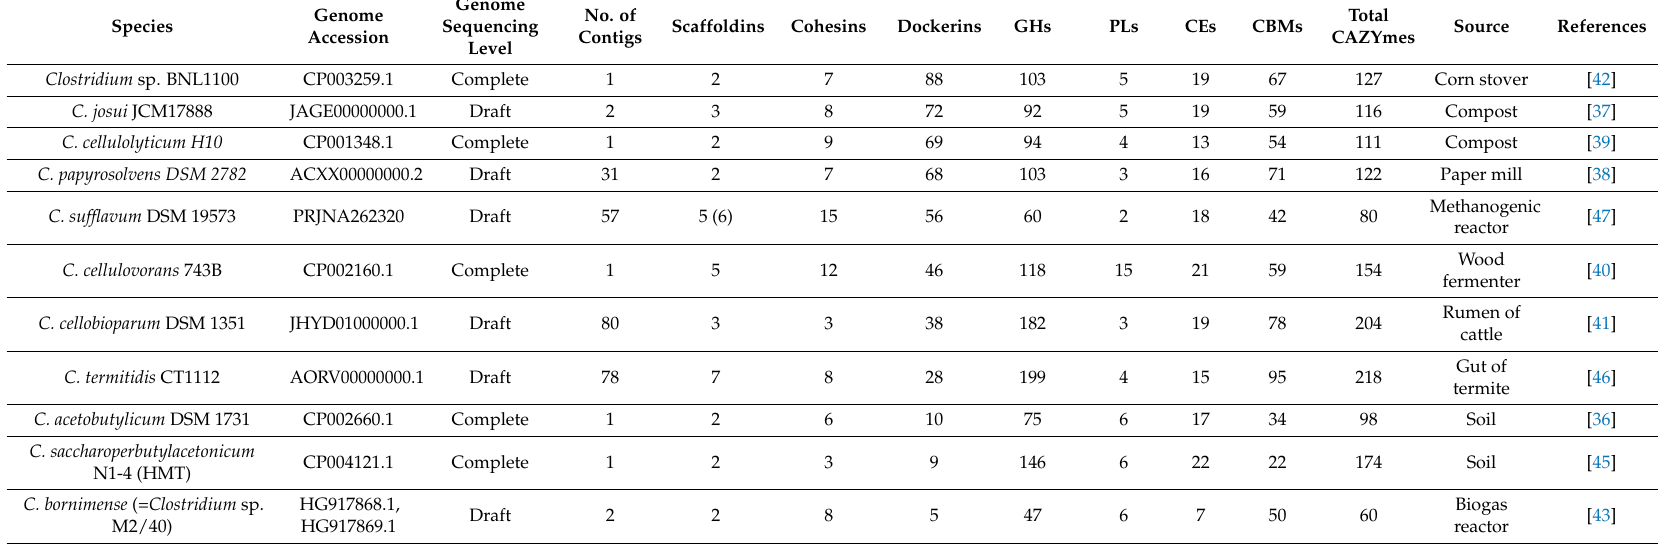
Table 1. Cellulosomal and CAZy metrics of the Clostridia mesophiles analyzed in this